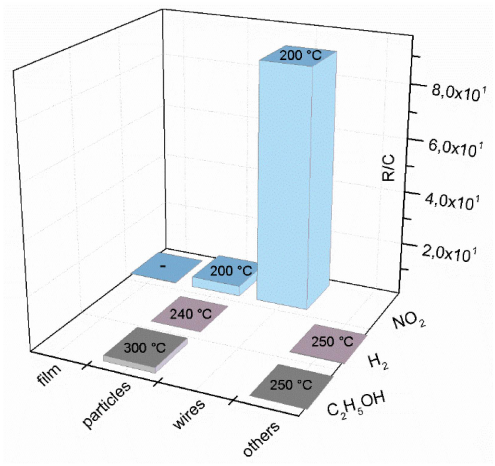
Figure 6. Relative sensor response (R) to ppm concentration (C) of H 2 , C 2 H 5 OH and NO 2 against operating temperature for different tin oxide morphologies (based on the maximum response for the minimum concentration shown in Table for each morphology/gas combination). Other structures: NR and